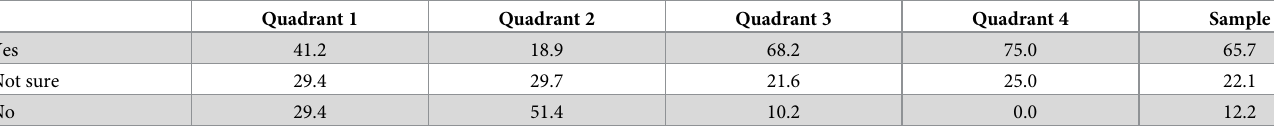
Table 5. I 3 vaccine classification and willingness to be vaccinated as soon as